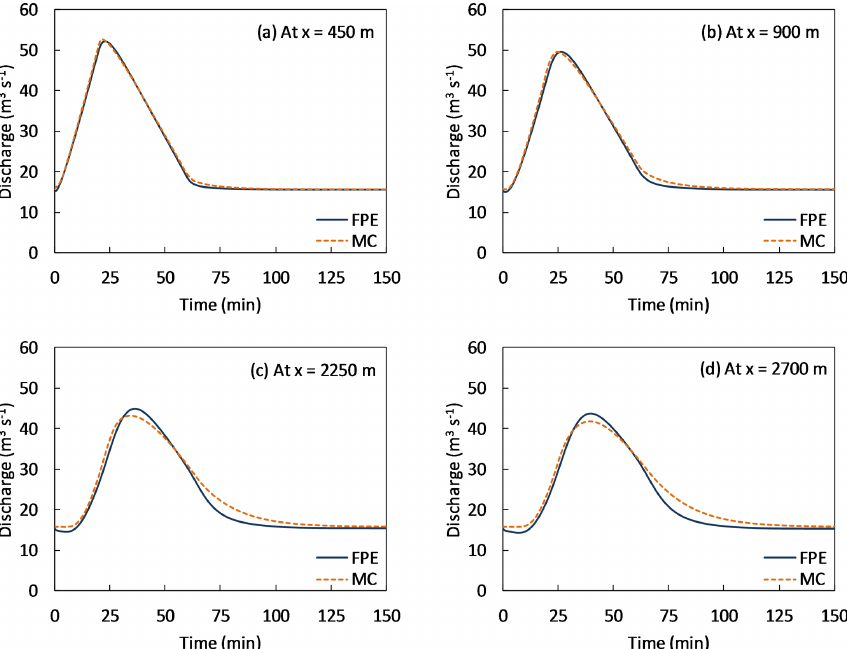
Figure 3. Comparison of the ensemble average discharge obtained by the FPE methodology and the MC approach as a function of time, at different channel